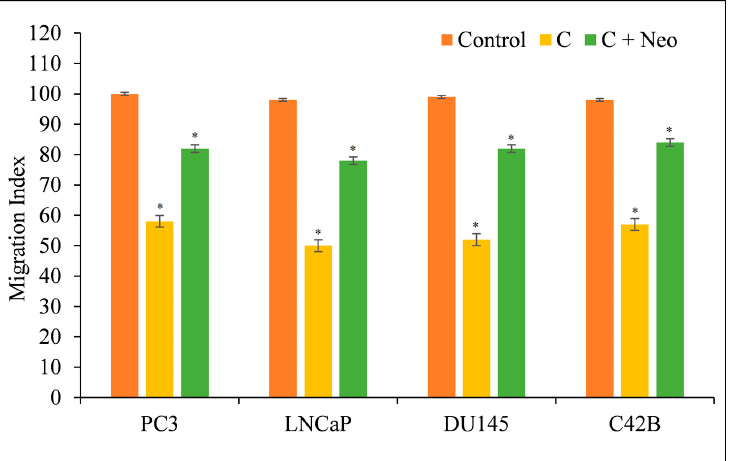
Figure 8. Curcumin’s effect on the migration of PC3, LNCaP, DU145, and C42B cancer cells in the presence of the copper chelator neocuproine. As mentioned in Section 2, a cell migration test was performed utilizing 24-well transwell permeable supports with 8 mm pores (Corning, NY, USA). In the presence and absence of curcumin (25 µ M) and neocuproine (50 µ M), the cells were developed. On an Ultra Multifunctional Microplate Reader, the fluorescence of the migrating cells was measured (TECAN, Durham, NC, USA). The stated values are the ± S.E.M. of three separate experiments. * p value < 0.05 in comparison to the control